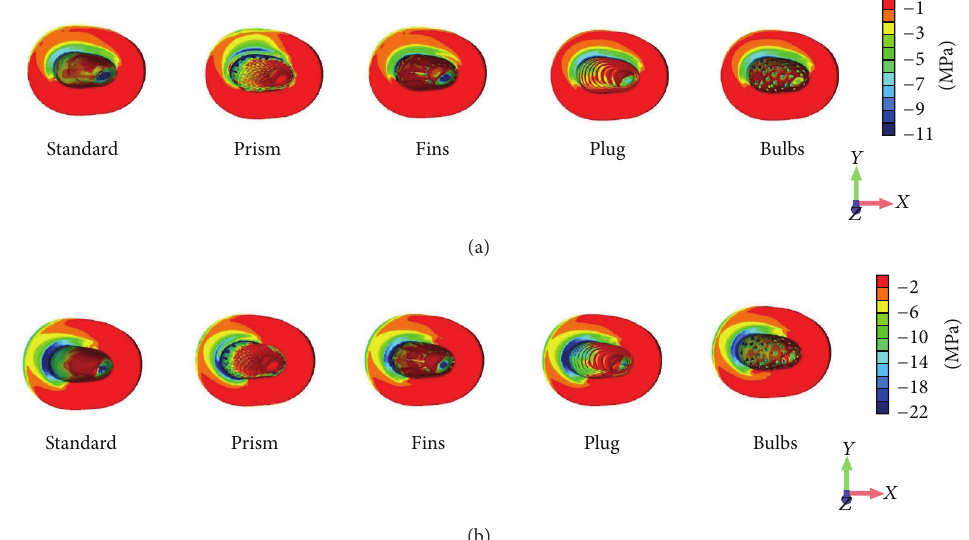
Figure 8: Distribution patterns of the compressive principal stress under vertical (a) and oblique (b) loading components.